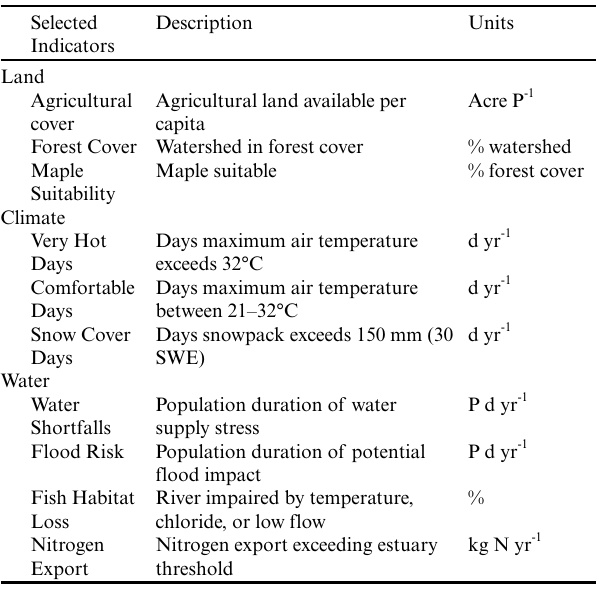
Table 2. Definitions and units of selected environmental indicators. (P = Person, d = day, yr =